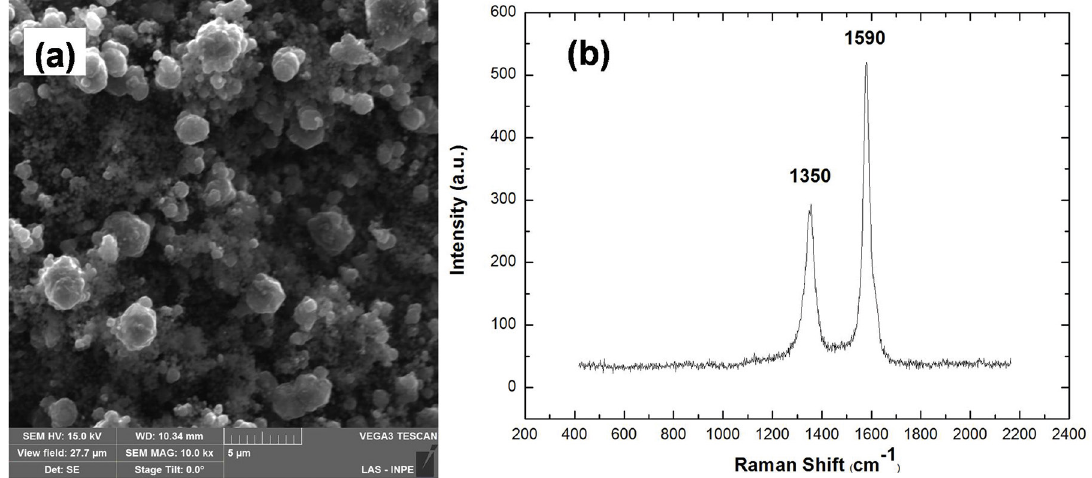
Figure 2. Diamond film on bare steel. (a) SEM image of diamond film on bare steel and (b) Raman spectrum of diamond film on bare steel.